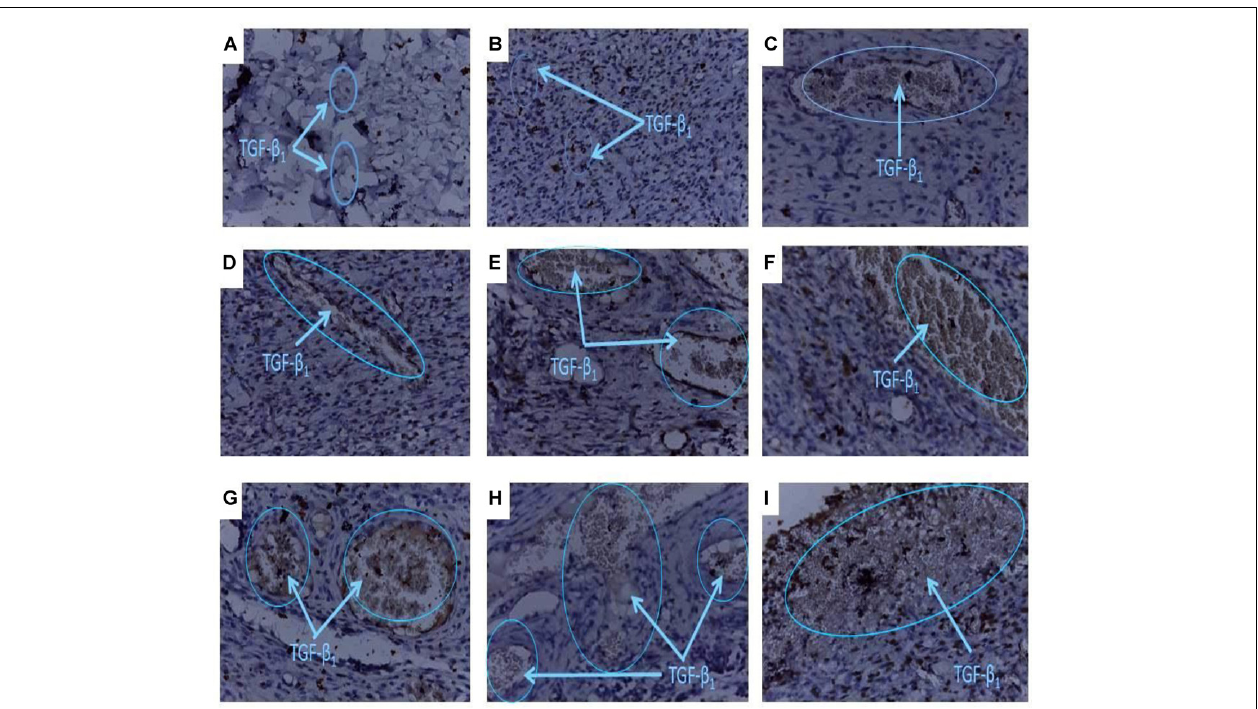
FIGURE 6 | Histology of wound tissues showing influence of PLE and geraniin on TGF- β 1 levels in excised wound tissues. Full thickness wounds were created on the dorsal region and topically treated with PLE, geraniin, silver sulphadiazine, vehicle (cream only). Wound tissues were excised on day 7 post wounding and sectioned. Serial sections were incubated in the primary antibody overnight. Sectioned tissues were then incubated in the biotinylated secondary antibody, which was further conjugated with HRP to form a complex. The addition of DAB to the complex produced a brownish chromophore and counter stained with Mayers haematoxylin. The slides were blindly examined under the microscope. Region of positive immunoreactivity (brownish chromophore) is indicated by the blue line. Representative images of the treatment groups revealed the following morphological features: (A) Untreated-wound tissues, (B) vehicle-treated (aqueous cream only) wound tissues, (C) 1% w/w silver sulphadiazine-treated wound tissues, (D) 0.25% w/w PLE-treated wound tissues, (E) 0.5% w/w PLE-treated wound tissues, (F) 1% w/w PLE-treated wound tissues, (G) 0.1% w/w geraniin-treated wound tissues, (H) – 0.2% w/w geraniin-treated wound tissues, and (I) 0.4% w/w geraniin-treated wound